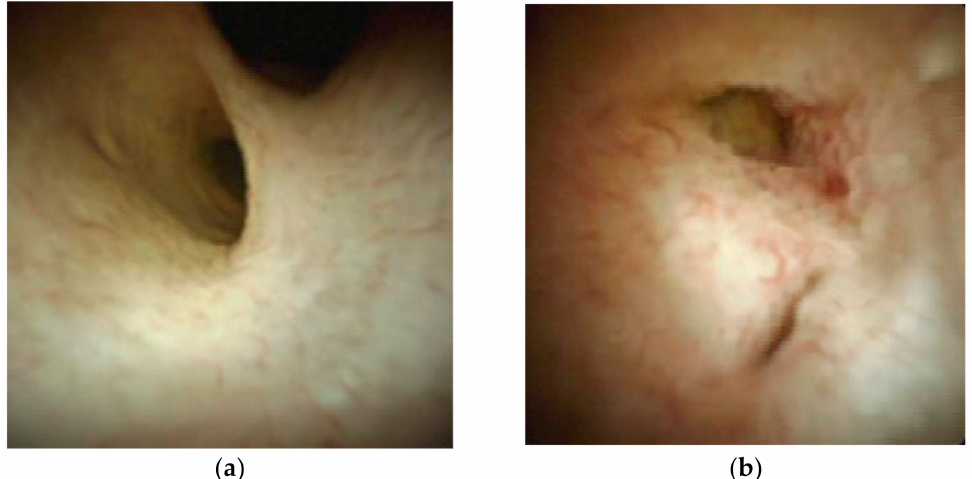
Figure 1. Indeterminate biliary strictures identified using Spy DS (SpyGlass DS Direct Visualization System). ( a ) A benign stricture showing a smooth surface and outline with no visible abnormal vessels. ( b ) A malignant stricture showing villous mucosal projections, irregular mucosal nodularity, and prominent